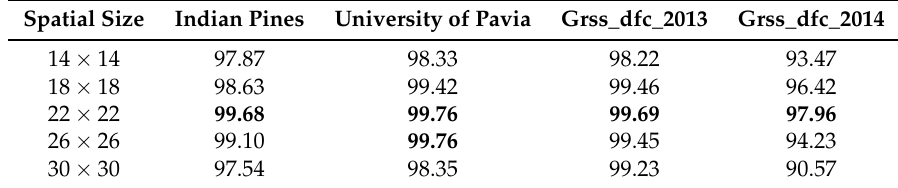
Table 10. OA of the proposed method with different spatial sizes.